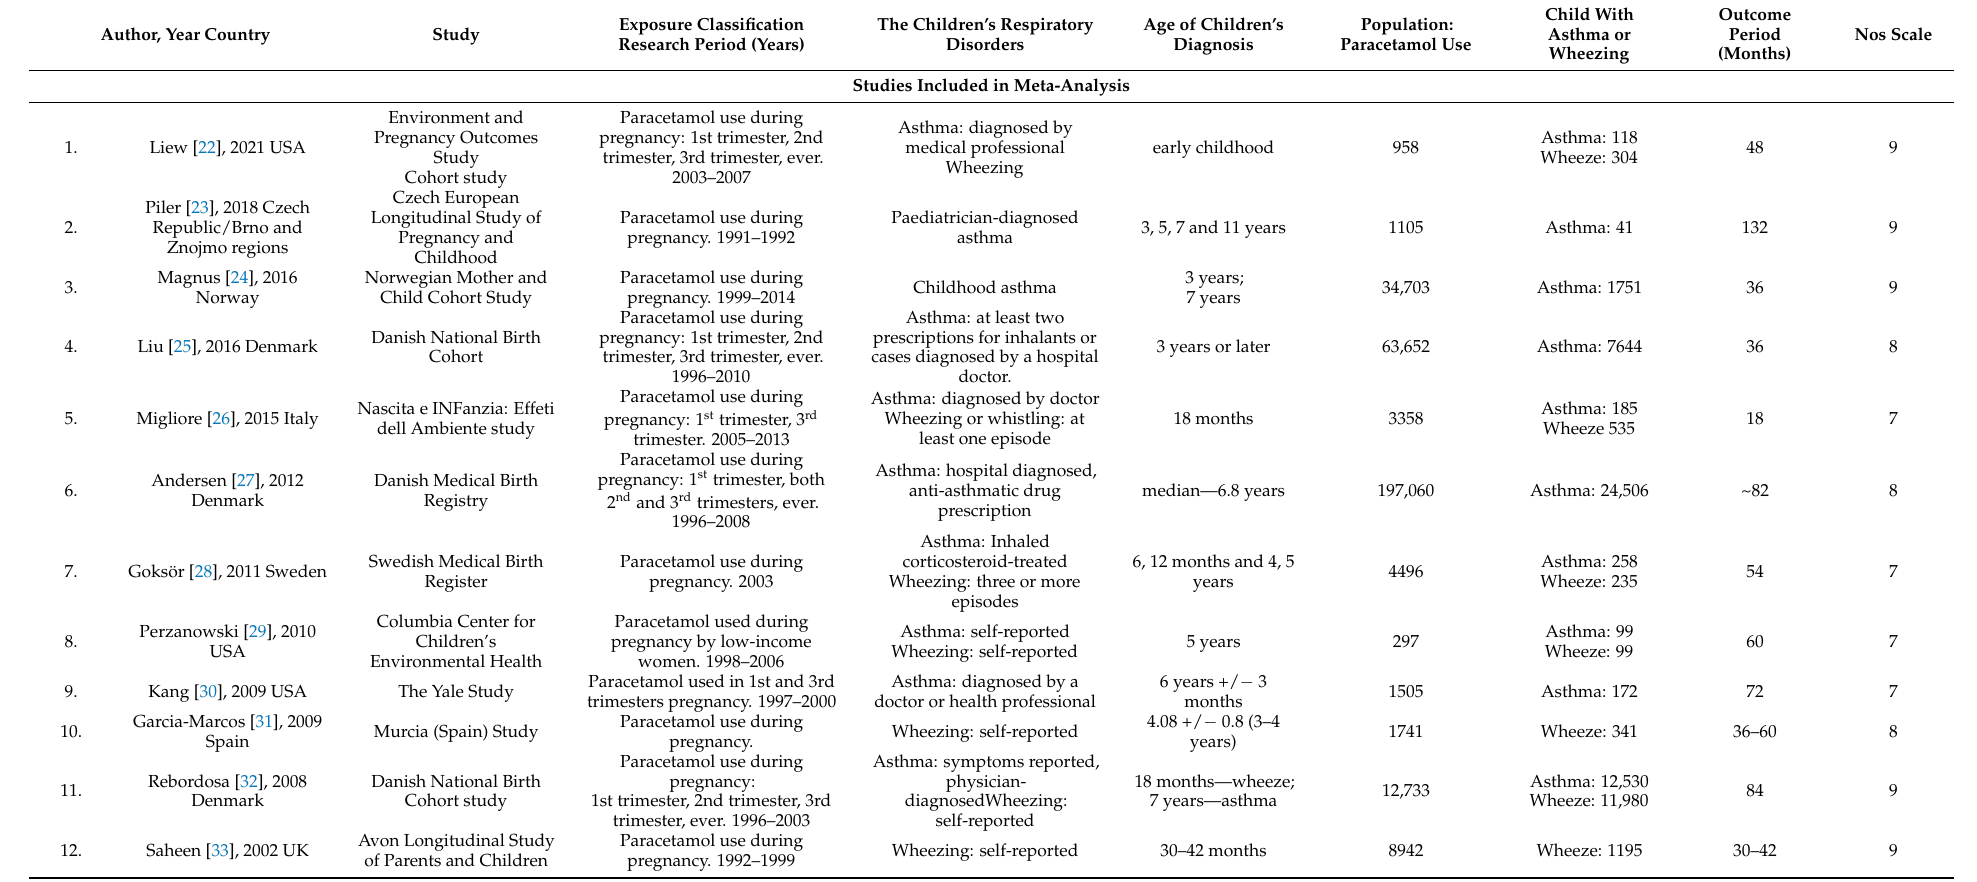
Table 1. Characteristics of included studies evaluating the association between prenatal paracetamol intake and asthma or wheezing risk in